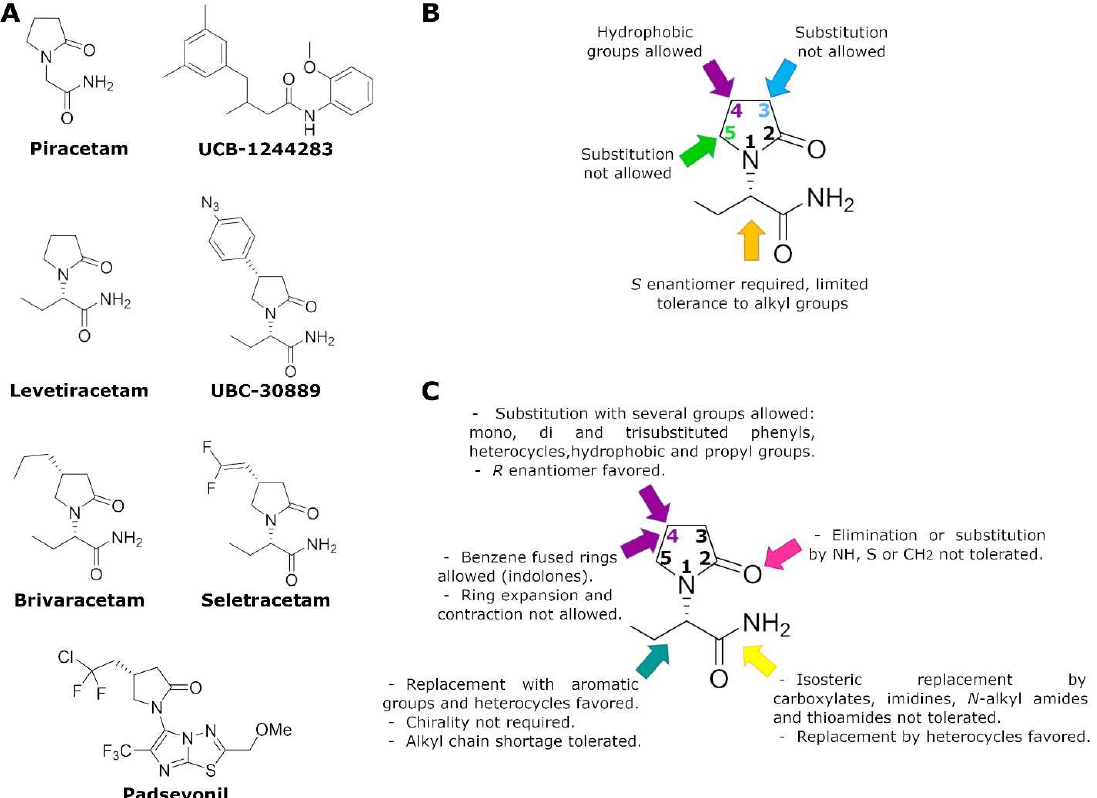
Figure 1. Chemical structures of racetams and molecular modifications. ( A ) Molecular structures of different SV2A ligands used in the text. ( B ) SAR map reported by Mittrapalli, 2014. ( C ) Updated SAR map according to our bibliographic search.